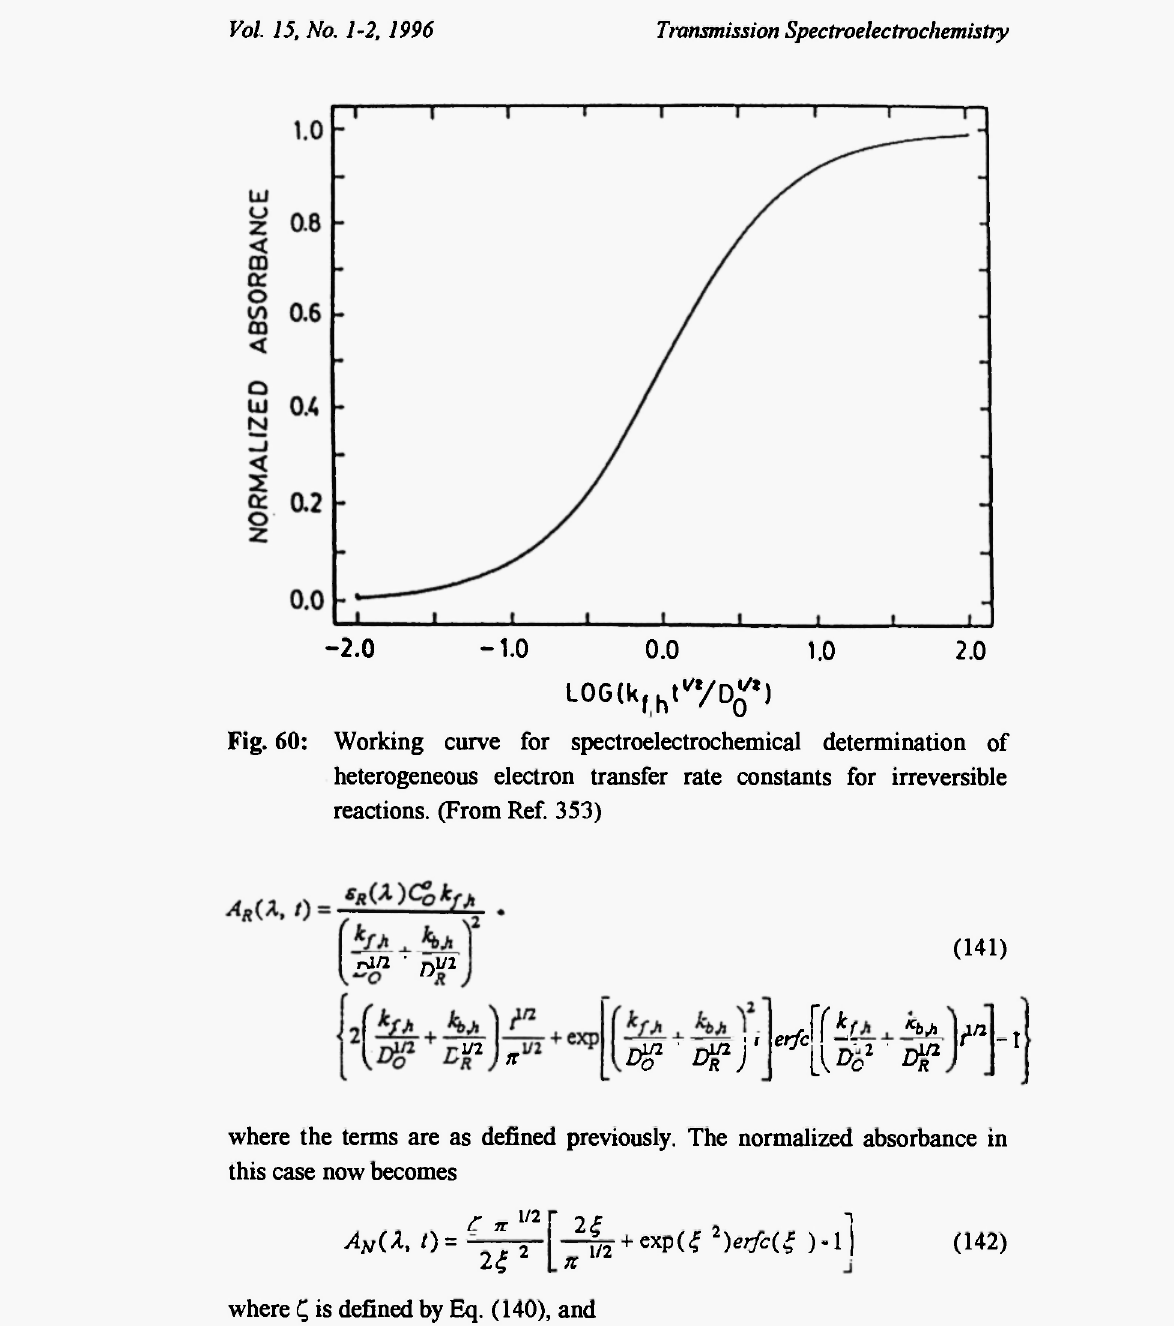
Fig. 60: Working curve for spectroelectrochemical determination of heterogeneous electron transfer rate constants for irreversible reactions. (From Ref.